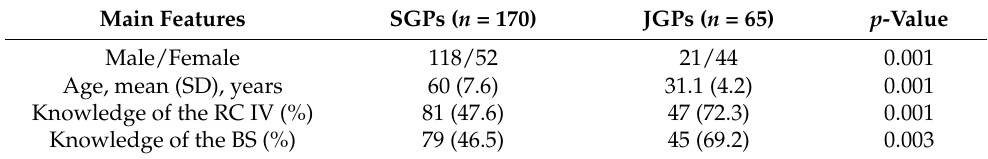
Table 3. Main features of SGPs and JGPs.